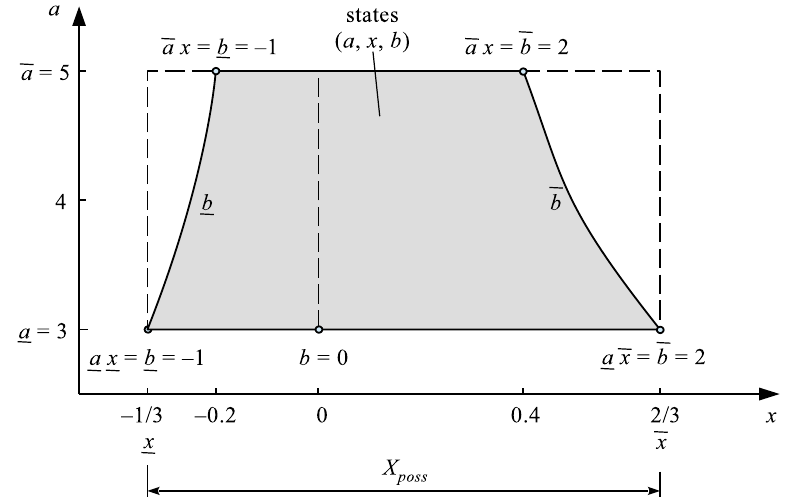
Figure 10. Set of possible states S = { ( a , b , x ) } of the system [ 3,5 ] x = [ − 1,0,2 ] in projection on the 2D-space A × X with range X poss of possible control values x .